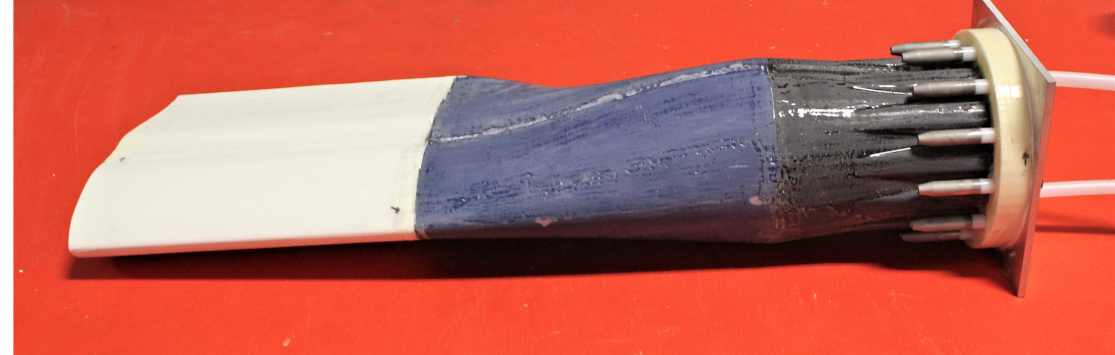
Figure 6. The 3D-printed mold sections after being sanded, sealed with epoxy, and fully assembled, ready for the composite manufacturing process. The root inserts were bolted in place for display purposes.